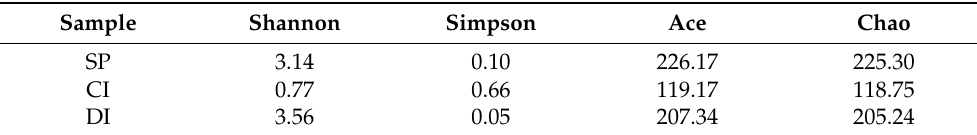
Table 3. Alpha-diversity indexes of the bacterial.